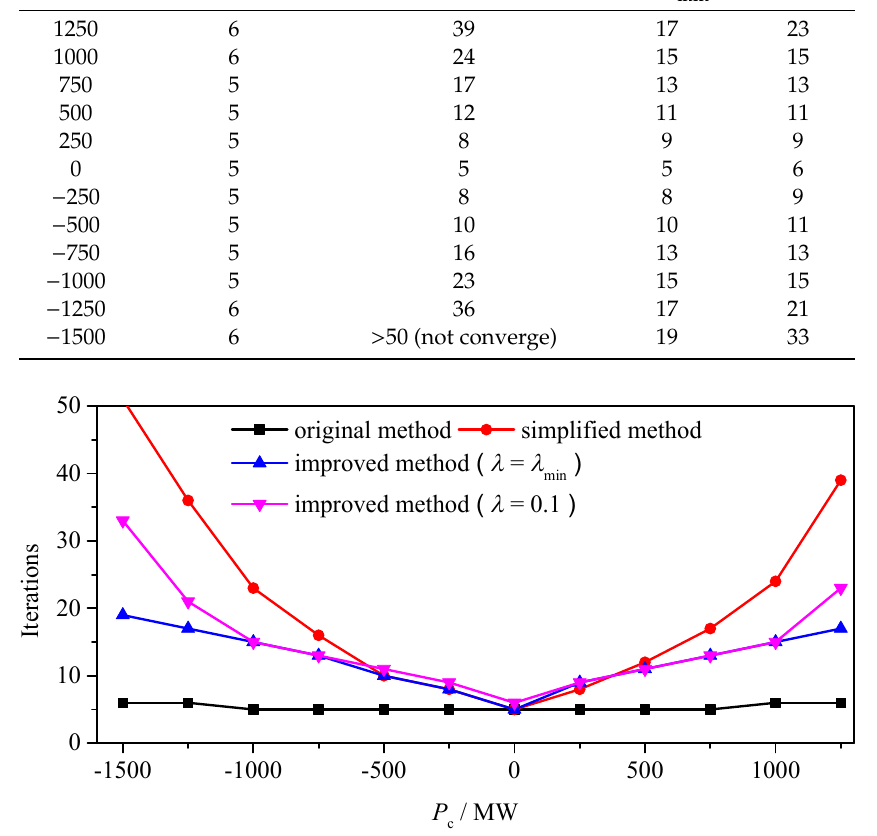
Figure 9. The comparison of iteration numbers under different Pc.